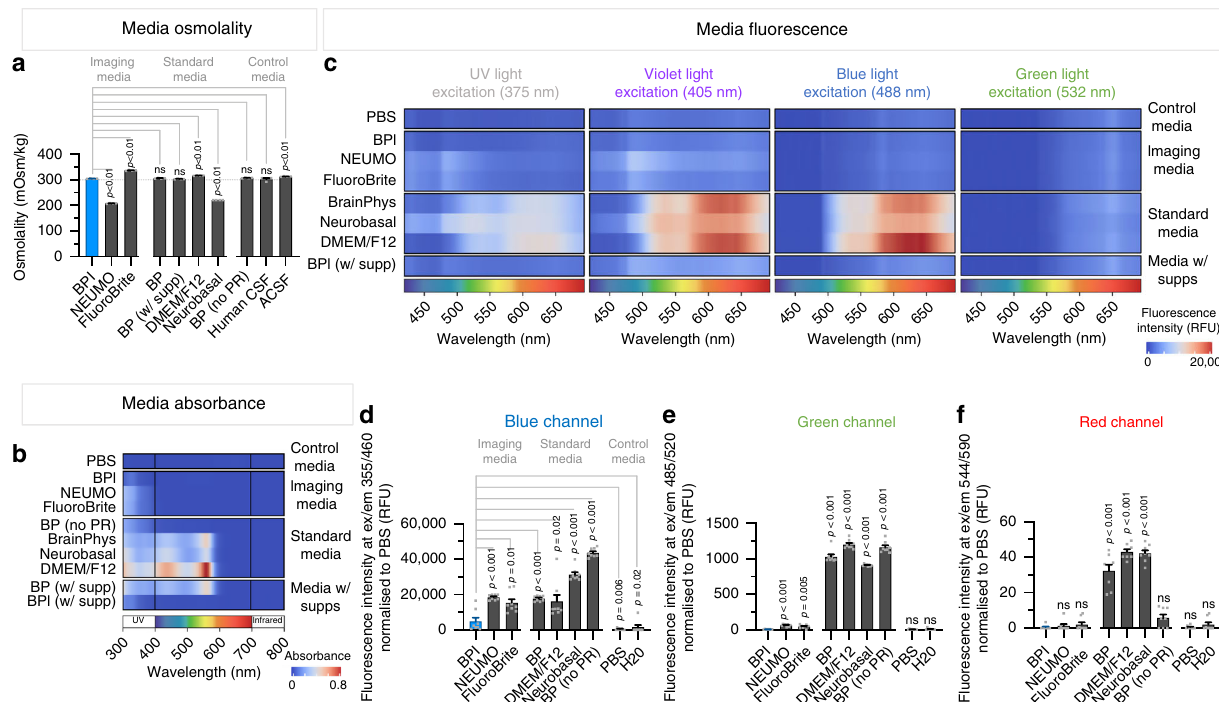
Fig. 1 BrainPhys Imaging reduces auto- fl uorescence and light absorbance. a The osmolality of BrainPhys Imaging (BPI) is similar to human cerebrospinal fl uid (hCSF) (~305 mOsmol/kg). Neurobasal and NEUMO were signi fi cantly lower (210 – 220 mOsmol/kg) and DMEM/F12 and FluoroBrite higher (317 – 338 mOsmol/kg). Media osmolality data was collected from four replicates per condition. A total of three hCSF samples, each pooled from up to four subjects, were tested across three independent experiments ( n = 3). See also Supplementary Fig. 1a. b – f Comparison of the optical properties of BPI with other basal media specialized for imaging (NEUMO, FluoroBrite), standard basal neuromedia (BrainPhys, BP; BrainPhys without phenol red, BP no PR; DMEM/F12; Neurobasal) and control media (phosphate-buffered saline, PBS; deionized water, H 2 O). b The absorbance spectra from 300 to 800 nm acquired from basal media alone (without cells), and after adding supplements required for the long-term culture of brain cells. Virtually all fl uorophores used for cell imaging require light stimulation above 300 nm. c – f The mean auto fl uorescence intensities of basal media (without cells) across the entire visible spectrum. BPI shows auto fl uorescence intensities similar to PBS. c The emission spectra across 400 – 700 nm captured for the 375 (ultra-violet), 405 (violet), 488 (blue), and 532 nm (green) excitation wavelengths from test and control media. d – f Auto fl uorescence at 460, 520, and 590 nm